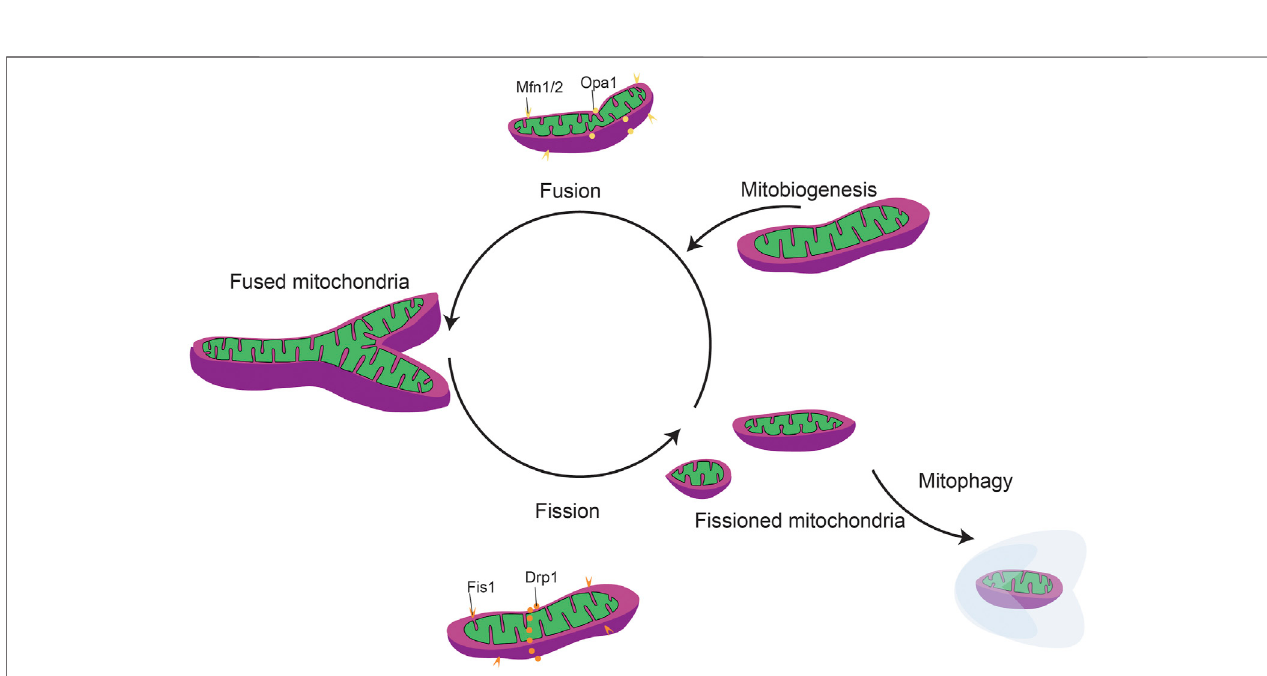
FIGURE 5 | General mitochondrial fi ssion and fusion dynamics. Mitochondrial dynamics include mitobiogeneis, mitochondrial fi ssion/fusion, and mitophagy.